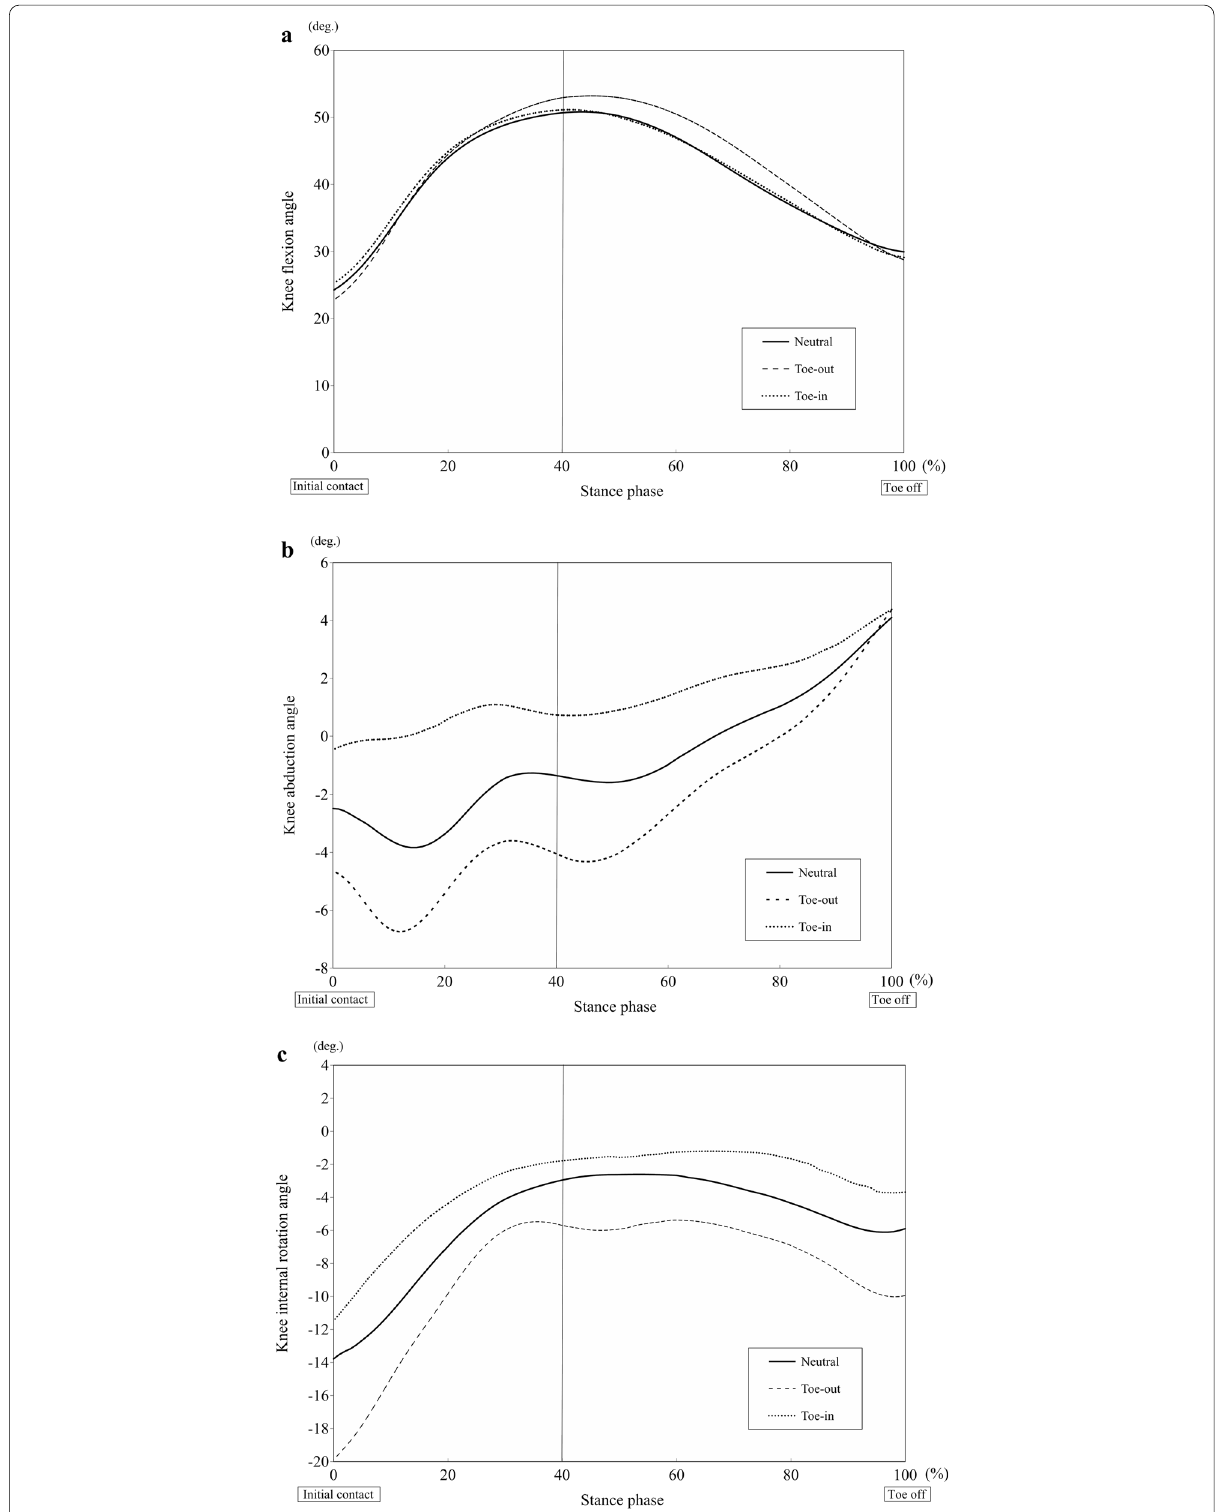
Fig. 2 Waveforms showing the average knee flexion angle ( a ), knee abduction angle ( b ), and knee internal rotation angle ( c ) during the stance phase of the cutting